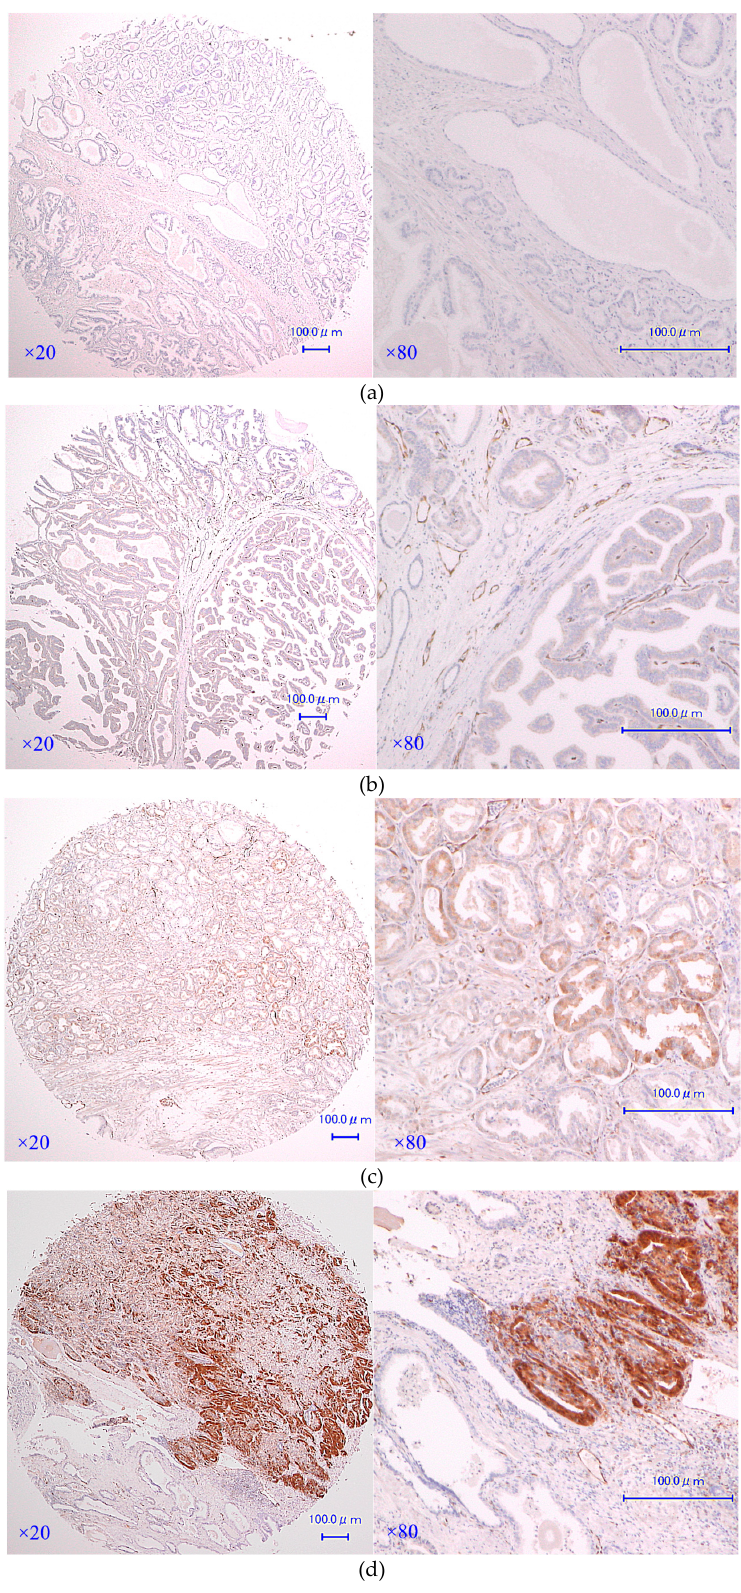
Figure 1. Representative immunostainings of aldo-keto reductase family 1 member C3 (AKR1C3): ( a ) score 0 (none staining), ( b ) score 1 (weak staining), ( c ) score 2 (intermediate staining), and ( d ) score 3 (strong staining).